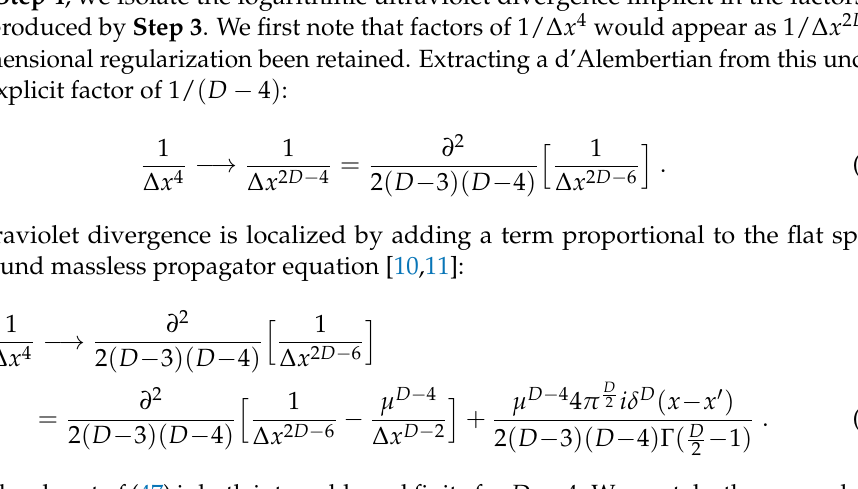
Table 6. Each of the tabulated terms must be multiplied by κ 2